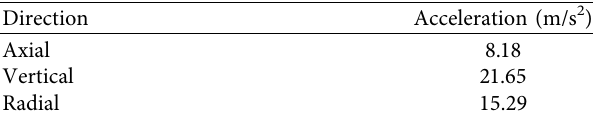
Table 2: Original vibration test